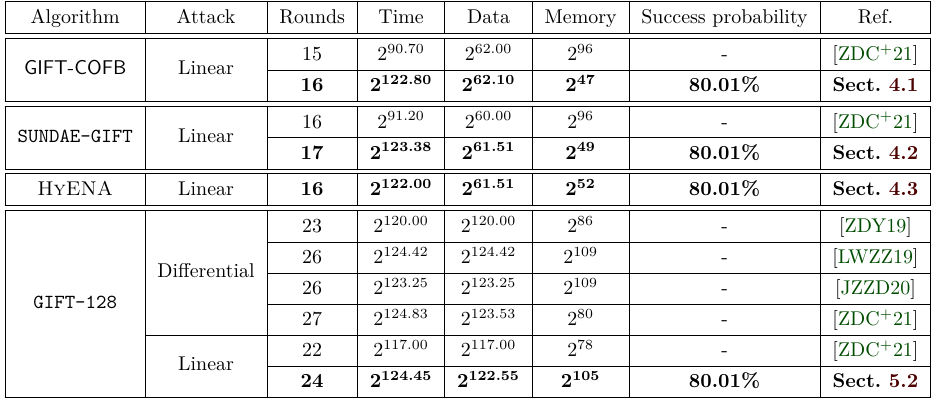
Table 1: Summary of the cryptanalytic results on the three AEADs and GIFT-128